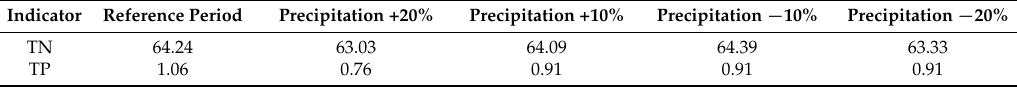
Table 8. The incidence of water pollution (%) under the Precipitation Change scenario.